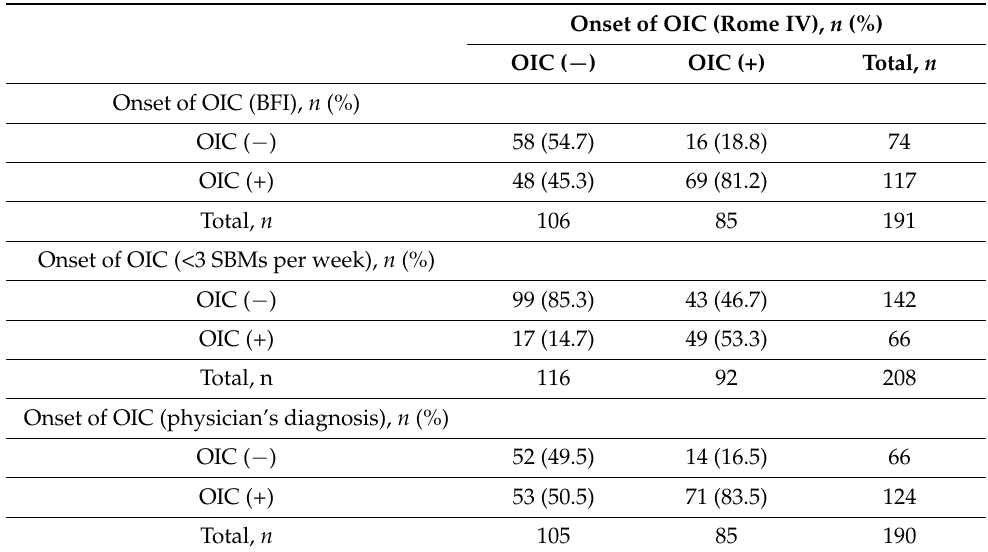
Table 1. Associations Between the Rome IV Criteria and BFI, SBMs, and Physician’s Diagnosis with Respect to the Identifying Patients with OIC (FAS 2 Population).